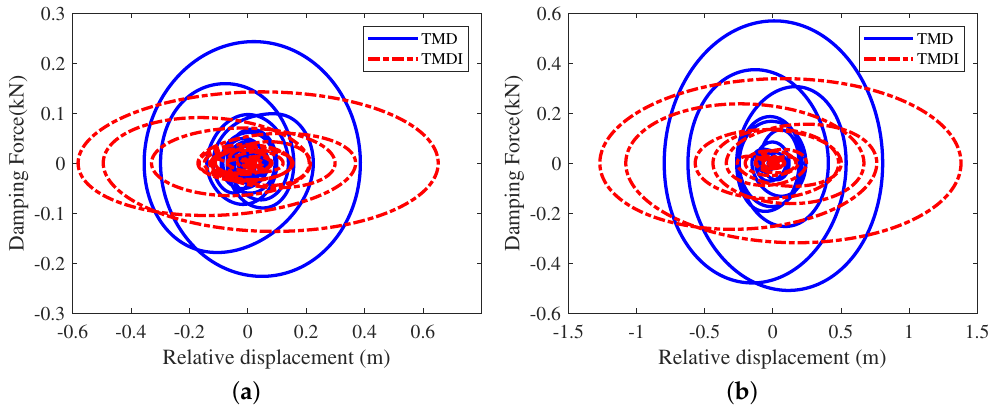
Figure 11. The hysteretic curve of damping element under different ground motion: ( a ) EL Centro and ( b )